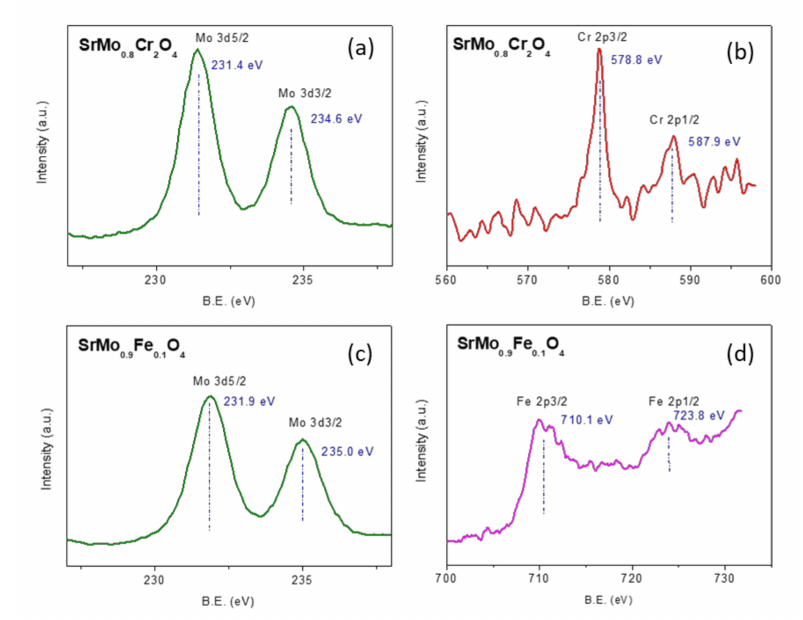
Figure 5. XPS core level spectra of Mo 3d ( a ) and Cr 2p ( b ) of SrMo 0.8 Cr 0.2 O 4, and Mo 3d ( c ) and Fe 2p ( d ) of SrMo 0.9 Fe 0.1 O 4.